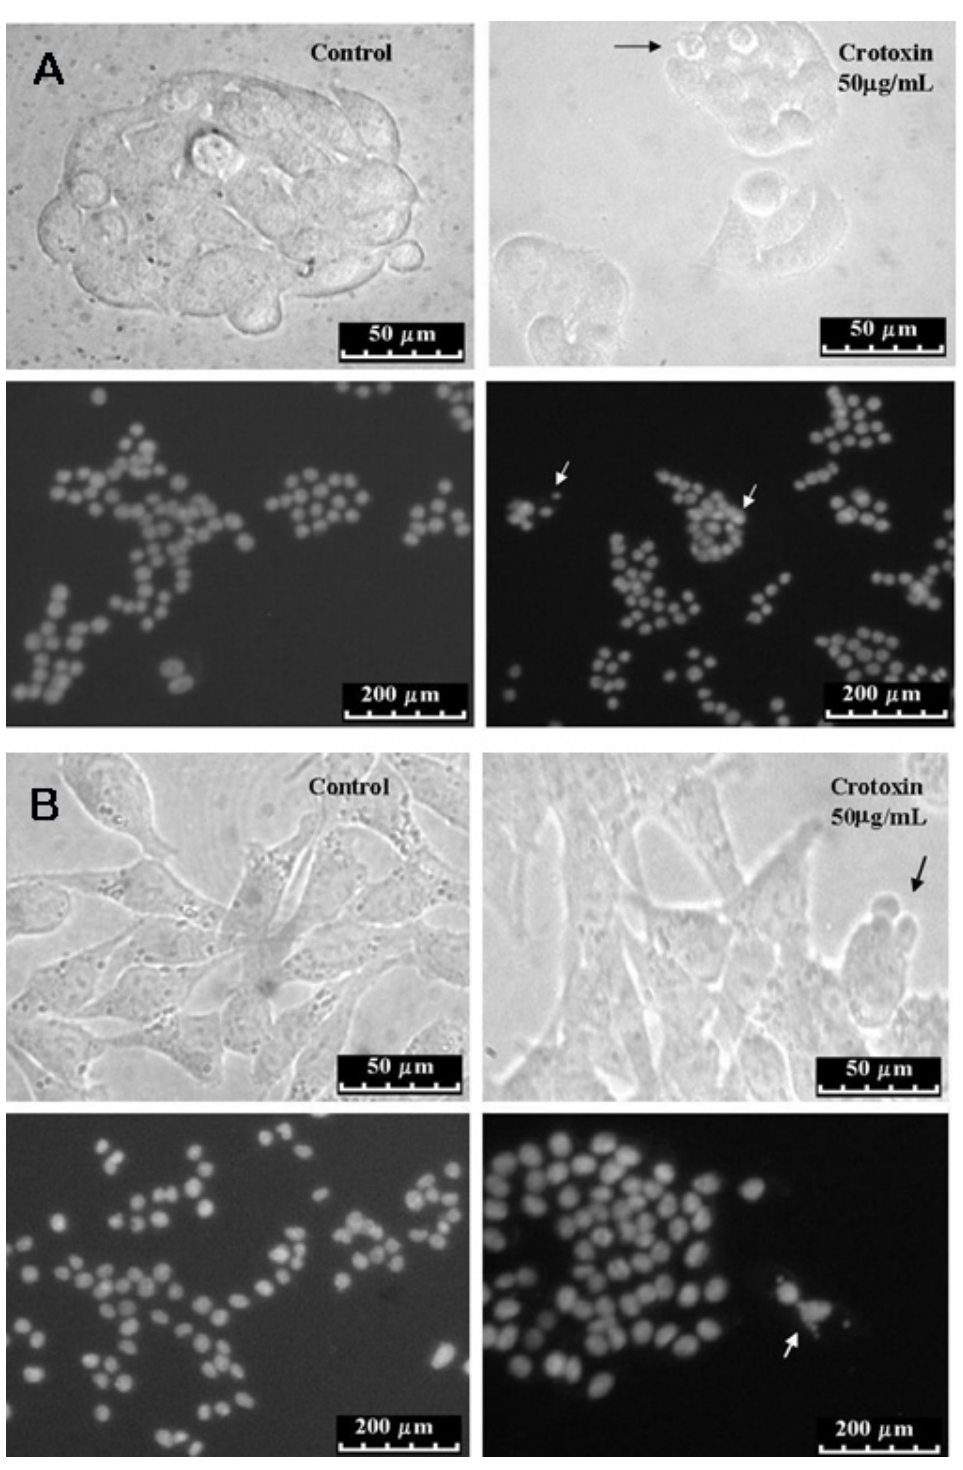
Figure 6. Crotoxin induces morphological changes and death in brain tumor cell lines: ( A ) GH3 cells and ( B ) RT2 cells. Brain tumor cells were treated with different crotoxin concentrations for 48 hours. Cell shrinkage, irregularity in cellular shape (indicated by black arrows), nuclear condensation and apoptotic body formation (indicated by white arrows) were seen in the crotoxin-treated